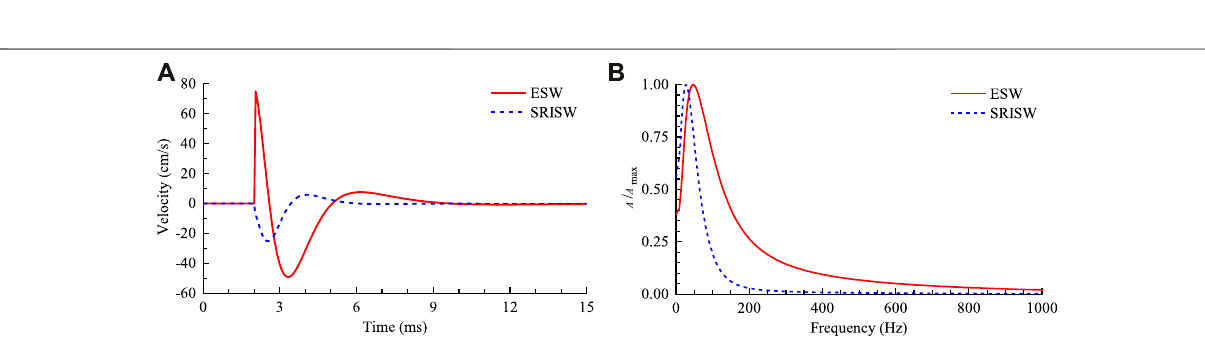
FIGURE 5 | Velocity history and PPV of the rock vibration induced by rapid in situ stress release. (A) Velocity history at r = 5 a , (B) PPV variation with distance.